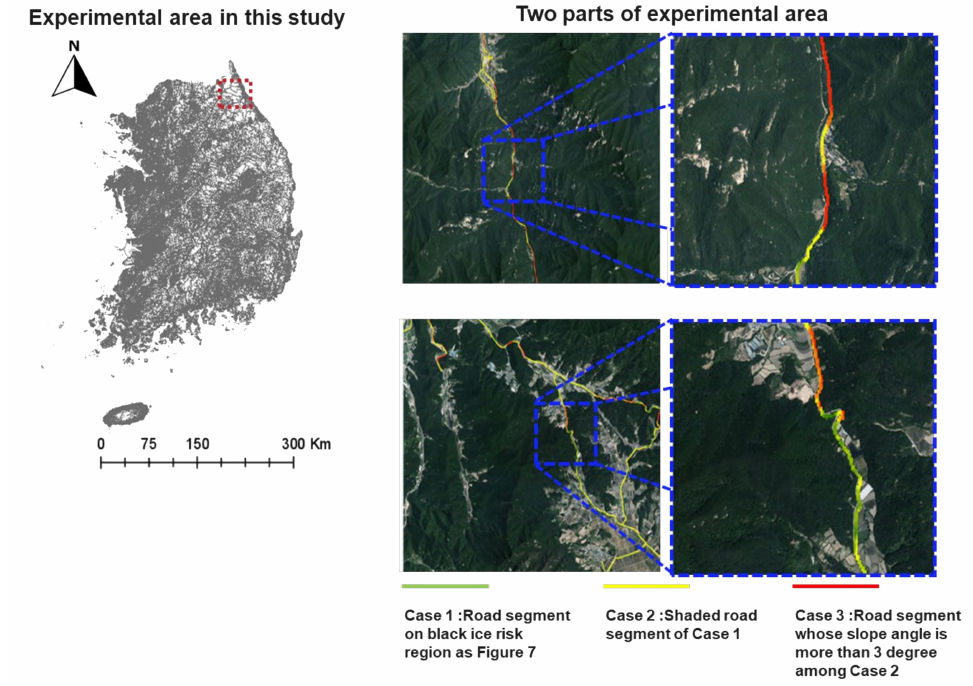
Figure 10. The testing area used in this